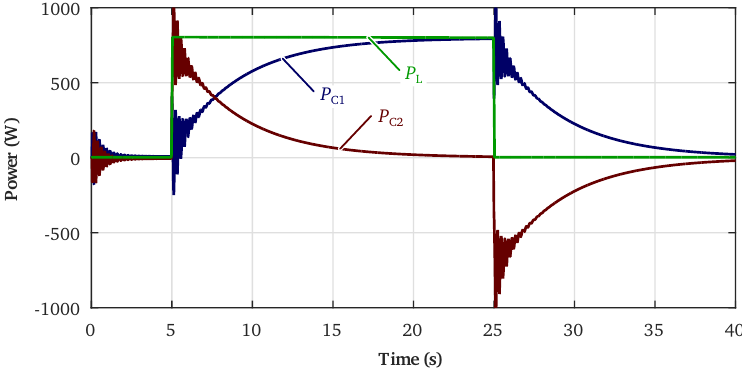
Figure 5. Supplied and load power with VSM control configured for different dynamic